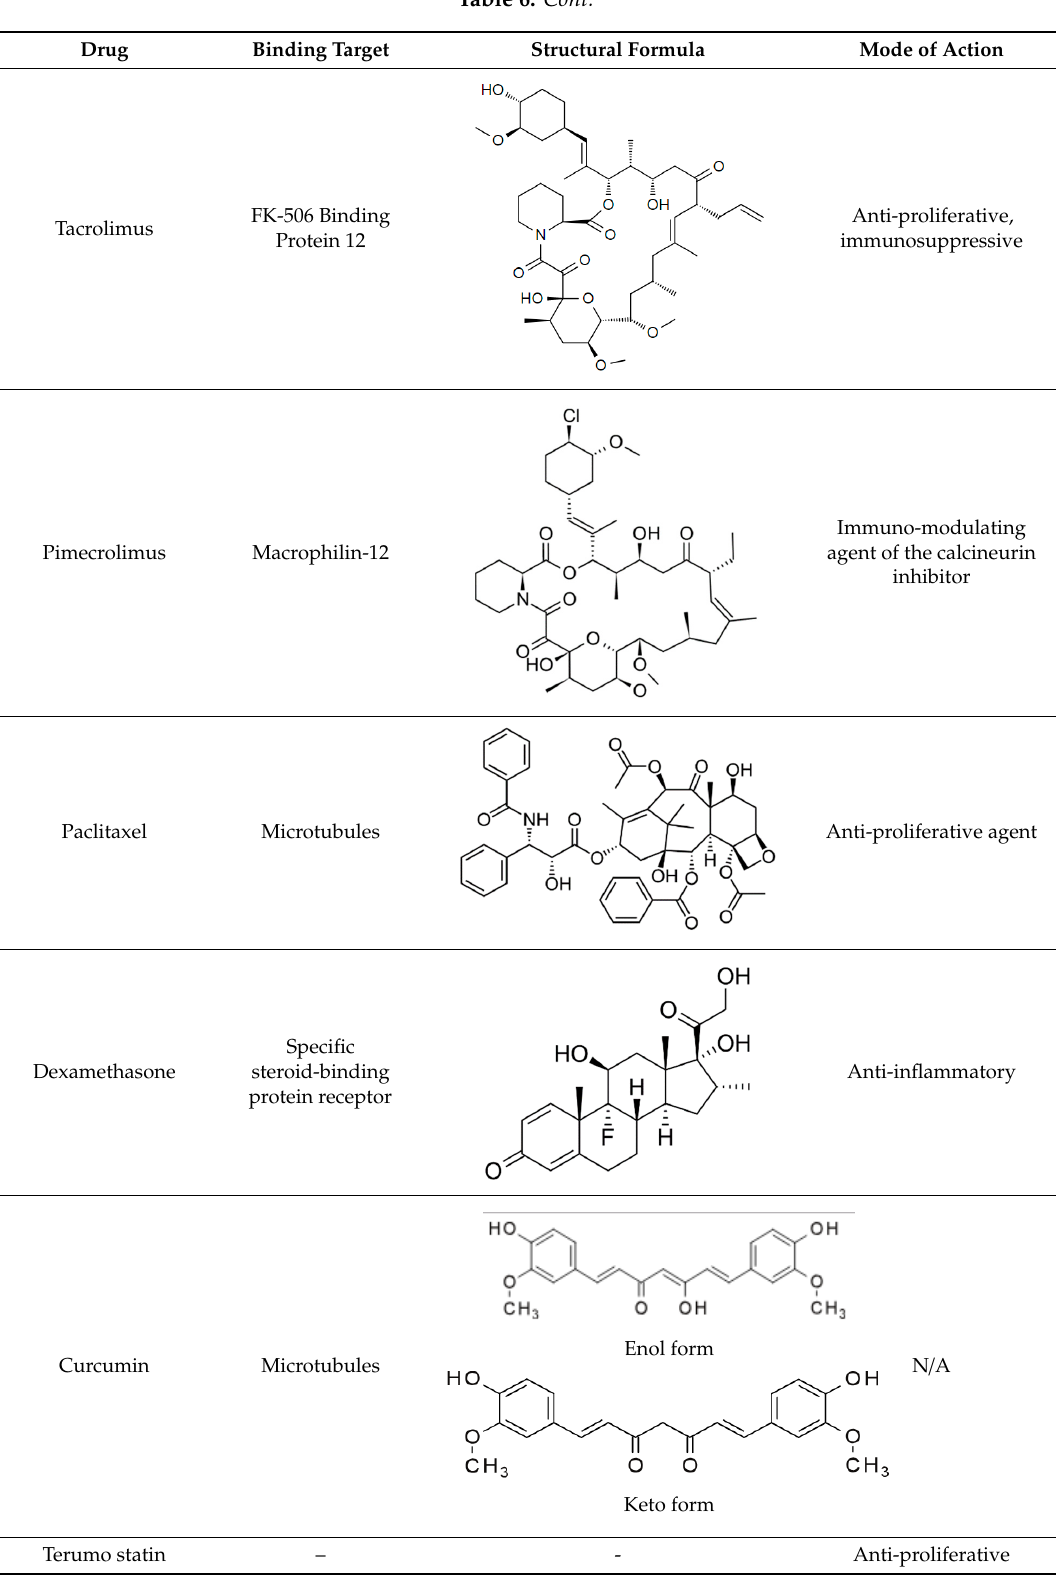
Table 6. Cont. Table 6. Drugs commonly used in DES. Table 6. Drugs commonly used in DES.